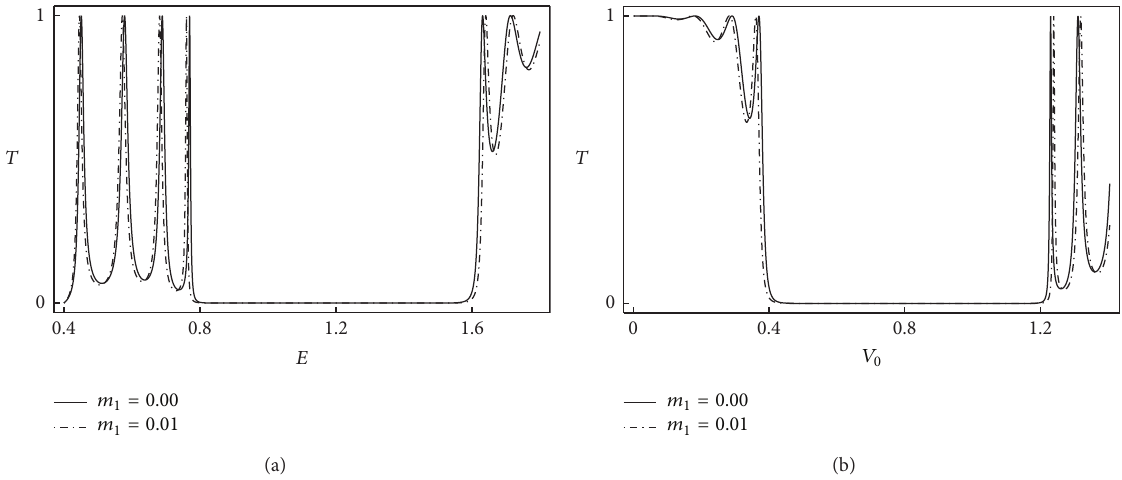
= 1 . (b) shows 𝐸 = 2 , 𝐿 = 1.2 , ̃ 𝐿 = 1.1 , 𝑎 = 10 , 𝑏 = 10 , 𝑝 = 2.2 , ̃ 𝑝 = 2.1 , 𝑞 = 1 , ̃𝑞 = 1 , and 𝑚 0